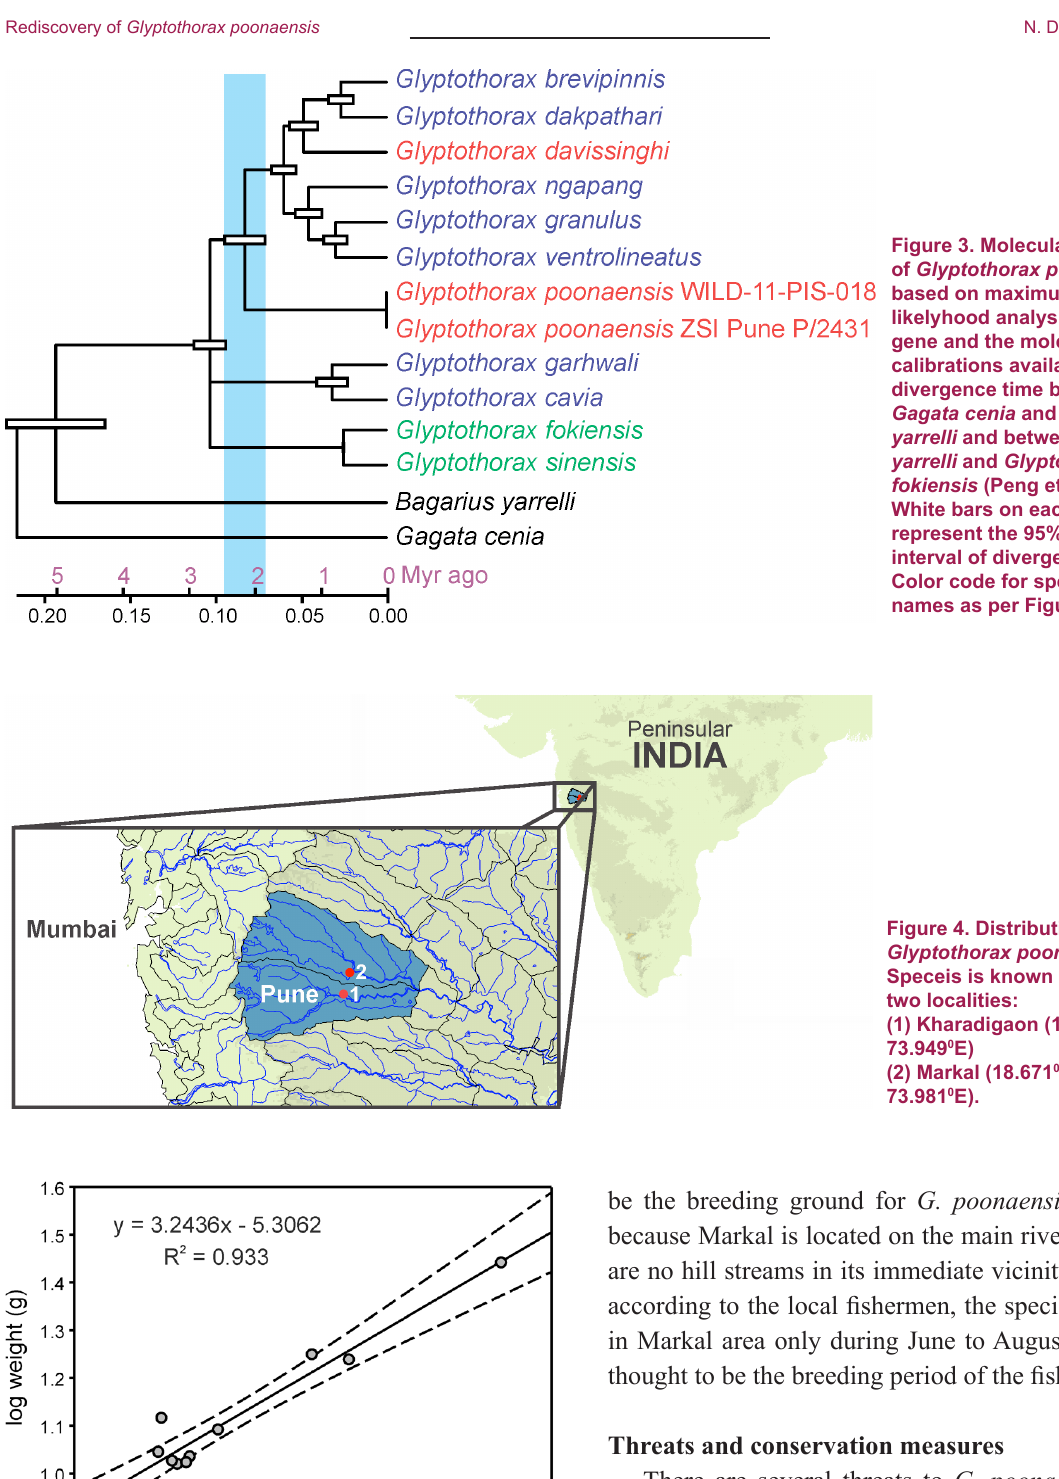
Figure 5. Length weight relationship of Glyptothorax poonaensis . Dashed lines indicate 95% confidence